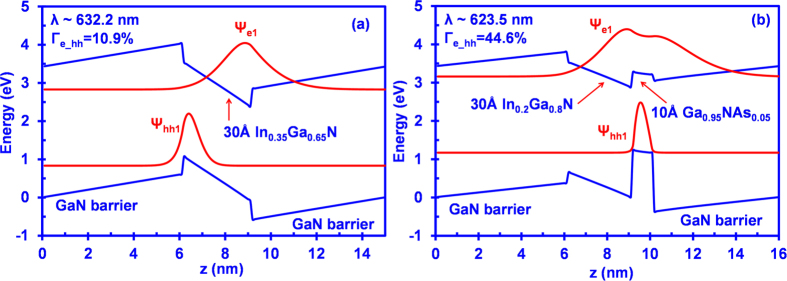
Energy band lineups of (a) conventional 30 Å In0.2Ga0.8N QW, and (b) 30 Å In0.2Ga0.8N/10 Å GaN0.95As0.05 QW with electron wave function (Ψe1) and hole wave function (Ψhh1).